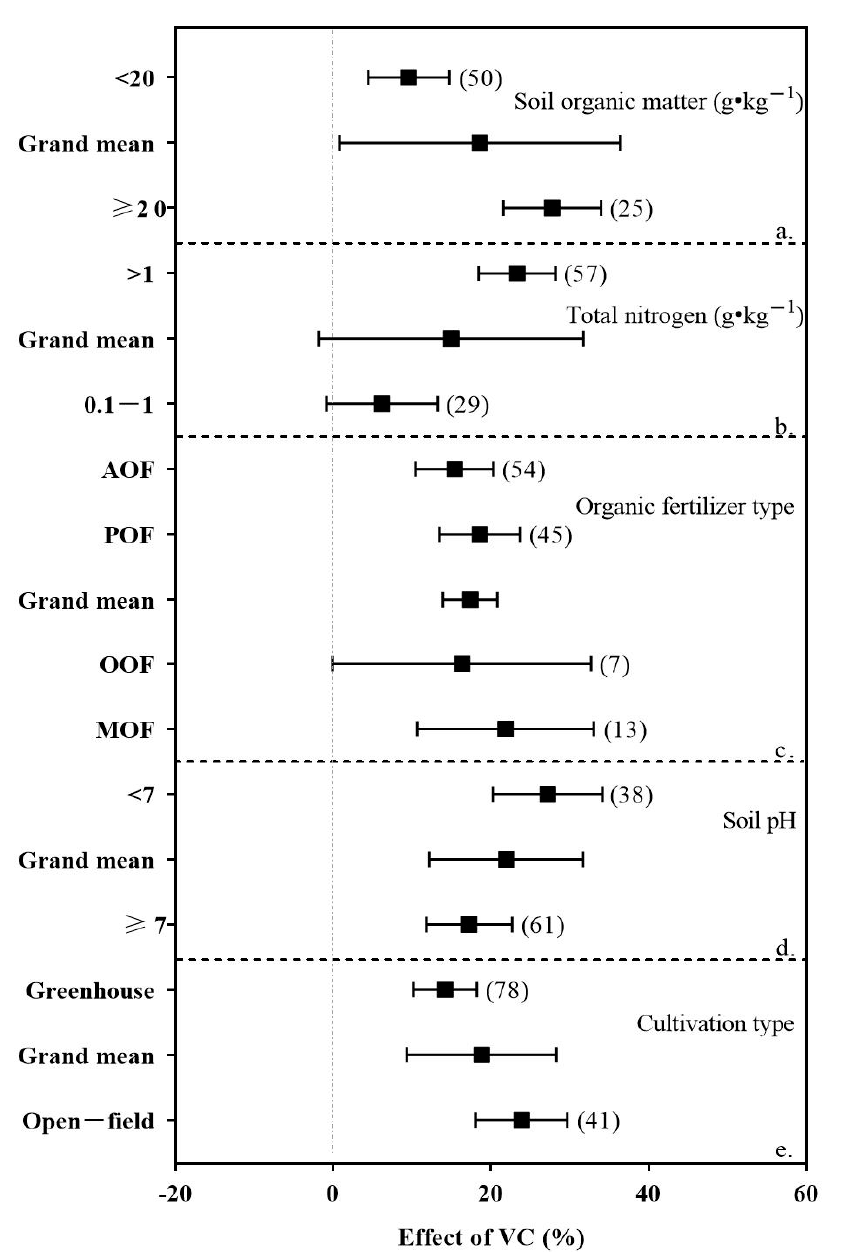
Figure 9. Organic fertilizers combined with soil organic matter ( a ), total soil nitrogen ( b ), type of organic fertilizers ( c ), soil pH ( d ), and cultivation type ( e ) on tomato VC (vitamin C) percentage changes. Points represent the mean effect, while bars represent 95% confidence intervals. The numbers on the right side of the confidence intervals represent the sample sizes. AOF, animal organic fertilizer; MOF, mixed animal and plant organic fertilizer; POF, plant organic fertilizer; OOF, other organic fertilizer.